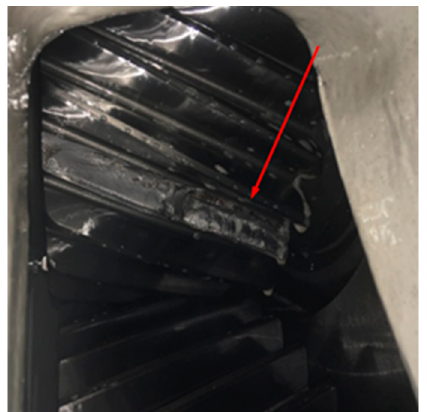
Figure 16. The liberated tooth of the pinion gear at gearbox parallel stage.